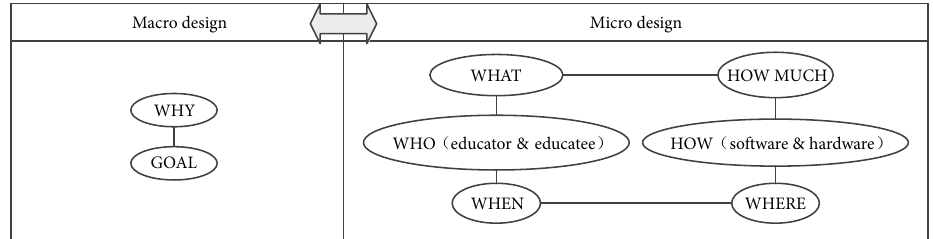
Figure 3. Framework diagram of the safety education design based on IFSE Table 4. Macro-analysis and micro-analysis of the safety education design